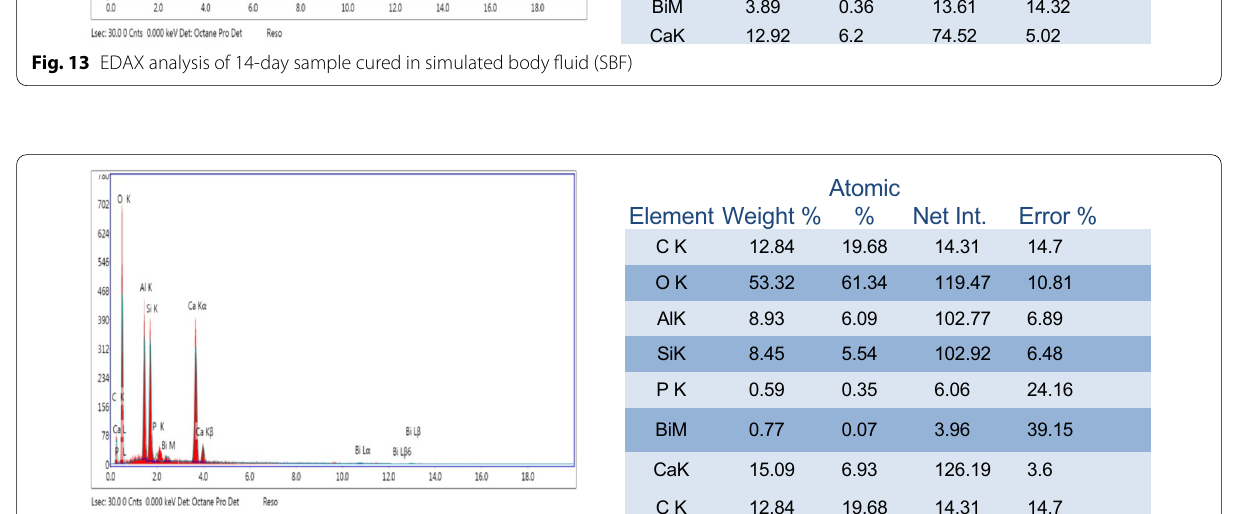
Fig. 14 EDAX analysis of 14-day sample cured in Pseudomonas aeruginosa in Mueller Hinton